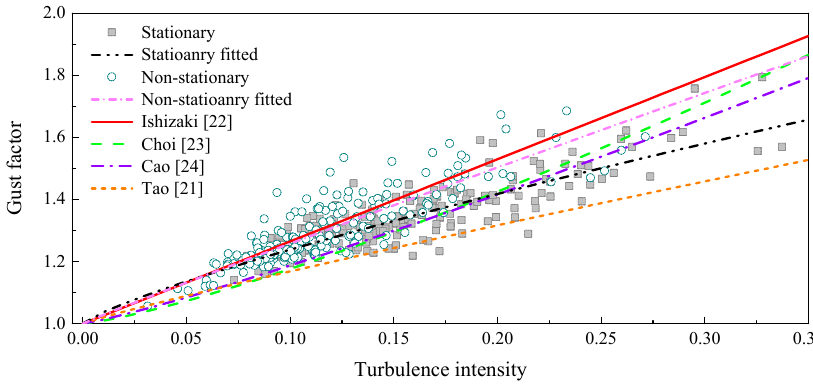
Figure 8. Stationary and non-stationary gust factors versus the turbulence intensity.